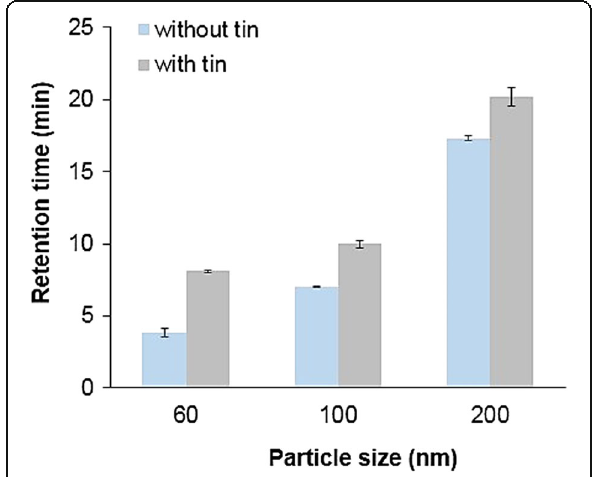
Fig. 5 The relationships between the retention time ( y -axis) and particle size ( x -axis) of different-sized silica nanoparticles in the absence of tin and incubated in tin. The fractionation was carried out using 0.25 mM ammonium carbonate and 10 kDa RC as carrier solution and membrane, respectively